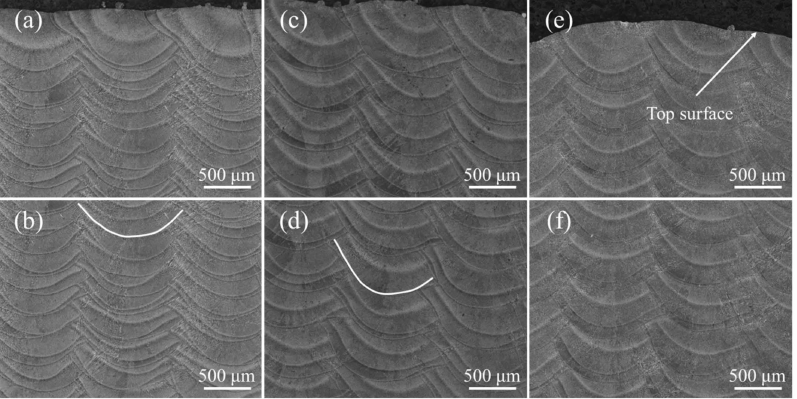
Figure 2. The microstructure with different z-increment: ( a , b ) 0.2 mm; ( c , d ) 0.4 mm; ( e , f ) 0.6 mm.